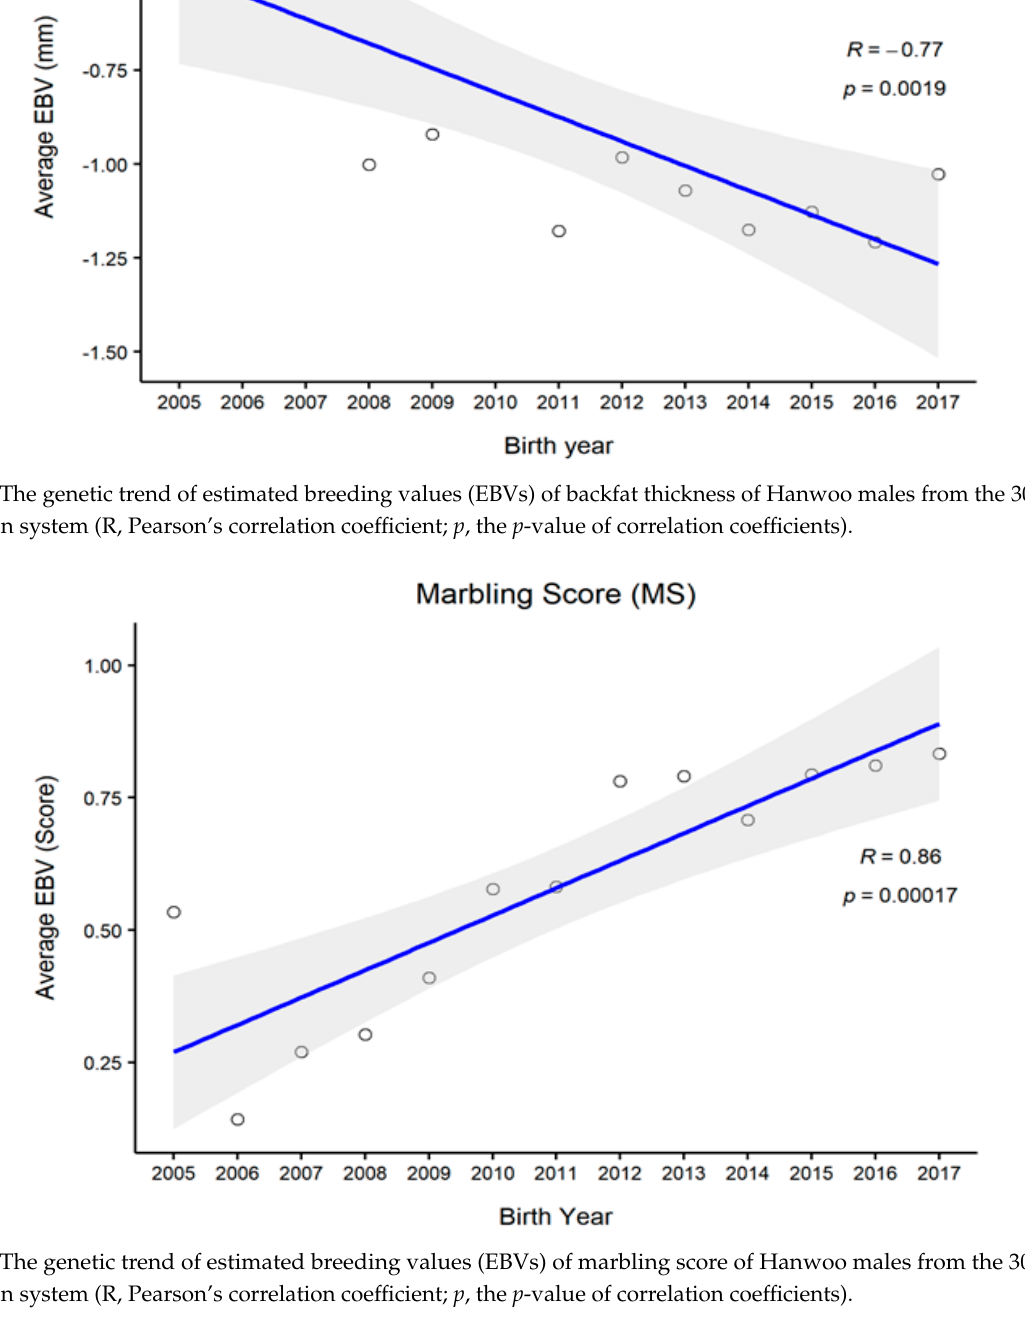
Figure 4. The genetic trend of estimated breeding values (EBVs) of marbling score of Hanwoo males from the 30-month production system (R, Pearson’s correlation coefficient; p , the p -value of correlation coefficients).